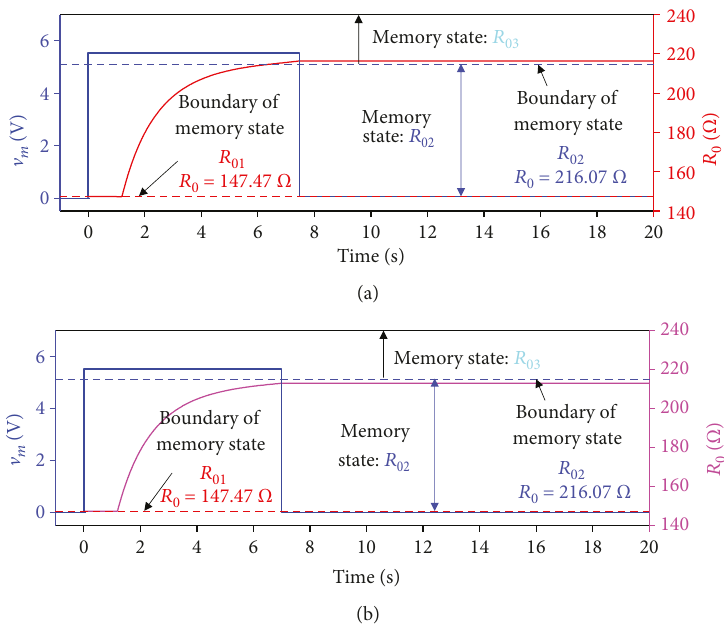
Figure 15: Switching kinetics of the memory states of real 6-lobe Chua corsage memristor emulator. (a) Successful switching: the corsage memristor emulator switches from memory state R pulse width Δ w = 7 5 s . (b) Switching failure: the proposed corsage memristor emulator fails to switch from R = 5 5 V and pulse width Δ w = 7 s as the resultant resistance R V A